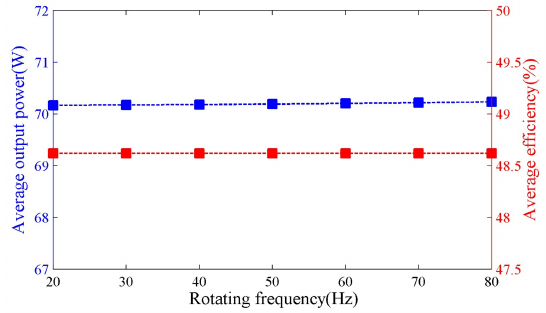
Figure 8. Average output power and average efficiency against rotating frequency in the single-receiver